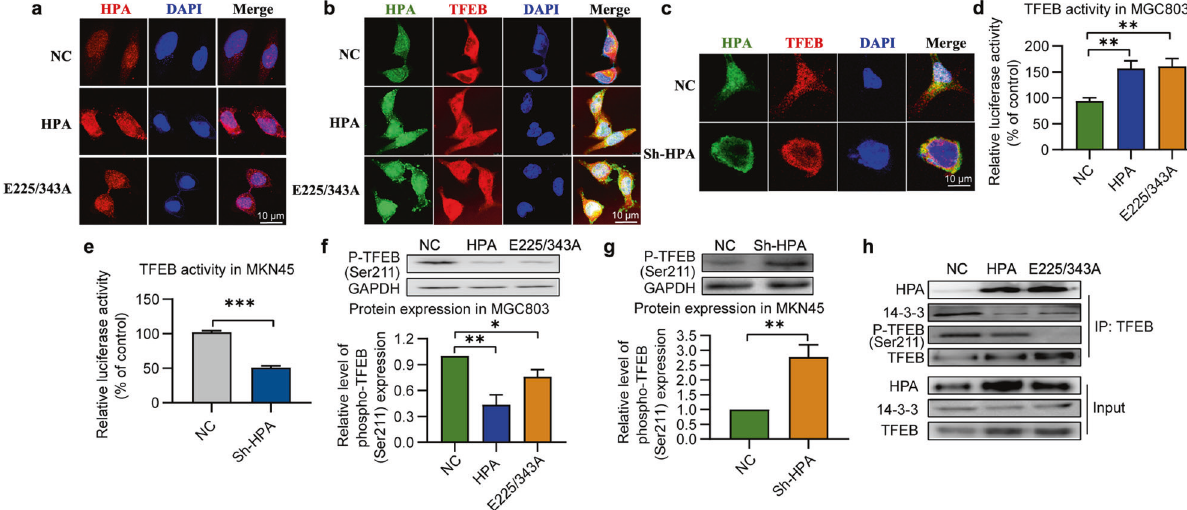
Fig. 6 Nonenzymatic HPA activates TFEB in a dephosphorylation-mediated manner. a Representative images of HPA subcellular localization in MGC803 cells after transfection with wild-type or mutant HPA. b Representative images of HPA and TFEB subcellular colocalization in MGC803 cells overexpressing native or mutant HPA or in MKN45 cells subjected to HPA knockdown ( c ), and starvation. Luciferase activity of TFEB was measured in starved MGC803 cells overexpressing native or mutant HPA ( d ) or in MKN45 cells after HPA knockdown ( e ). Representative immunoblot analysis and quanti fi cation analysis of phospho-TFEB(Ser211) in MGC803 cells overexpressing native or mutant HPA ( f ) or in MKN45 cells subjected to HPA knockdown ( g ), and starvation. h Cells overexpressing native or mutant HPA were lysed and subjected to immunoprecipitation with anti-TFEB antibody. Immunoprecipitates were analyzed by western blotting with anti-TFEB, or HPA, or phospho-TFEB (Ser211) or 14-3-3 antibodies. * P < 0.05, ** P < 0.01, *** P < 0.001 versus the NC